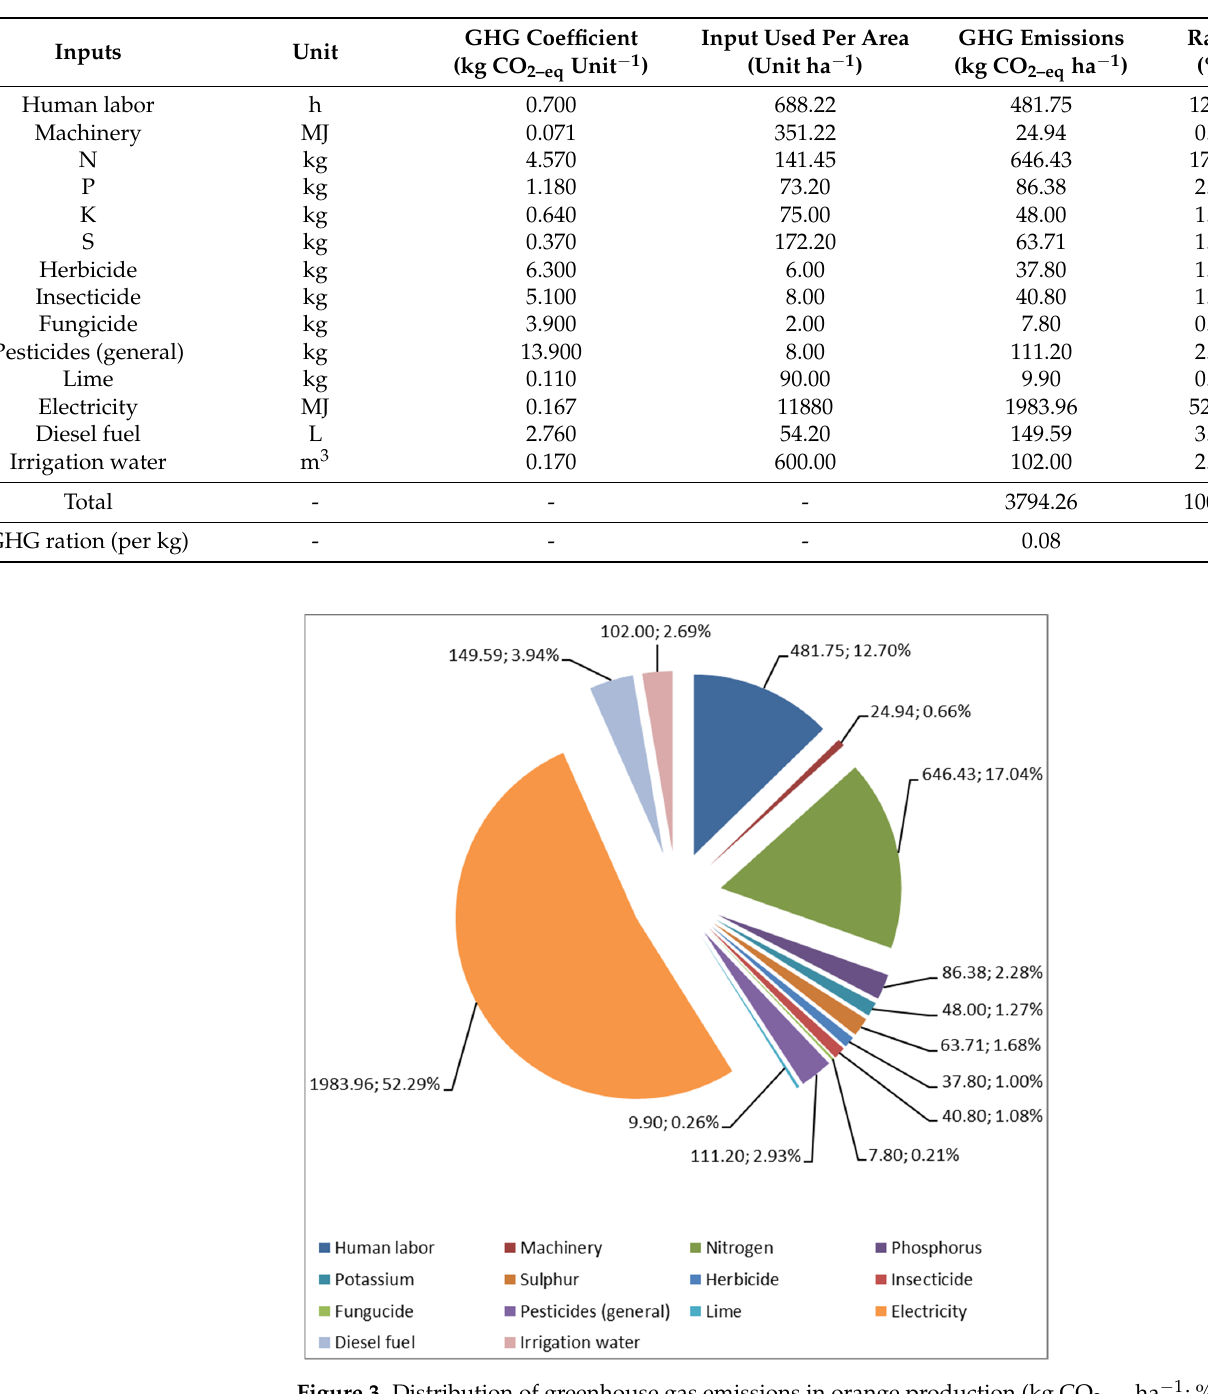
Table 6. Greenhouse gas emissions in the production of oranges.